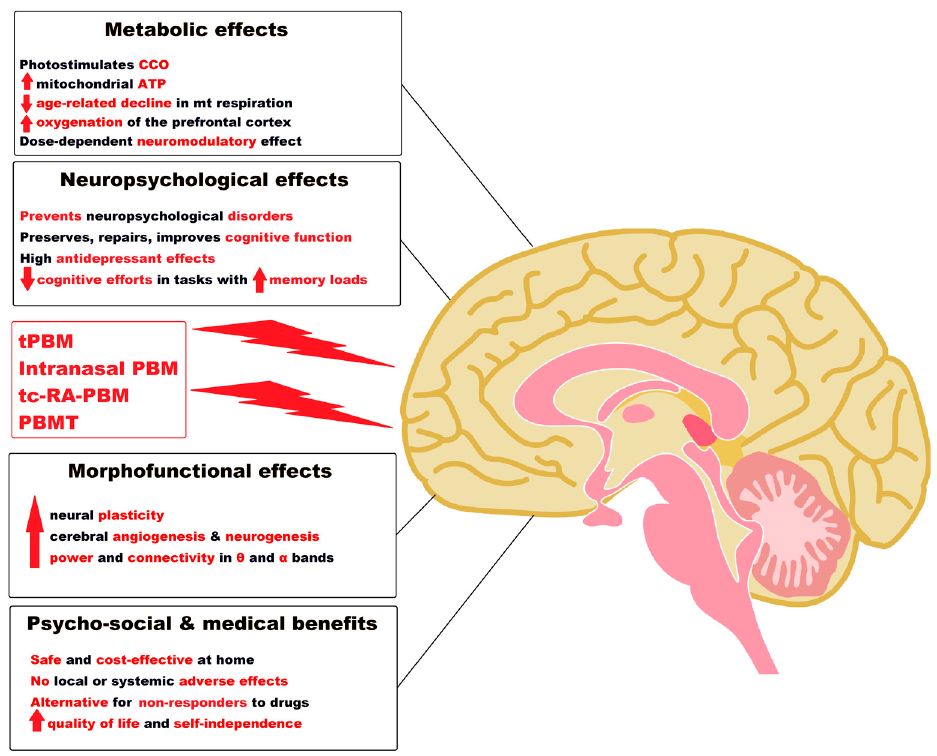
Figure 2. Notable effects of tPBM, intranasal PBM, tc-RA-PBM and PBMT as a “green” medicine in Alzheimer’s disease and dementia. Legend: ATP = Adenosine triphosphate; CCO = Cytochrome c oxidase; PBM= Photobiomodulation; mt = mitochondrial; tPBM = Transcranial PBM; tc-RA-PBM = Transcutaneous radial artery PBM; PBMT= Transcatheter Intracerebral PBM; α = alpha; θ = theta; ↑ = increase; ↓ = decrease. (Figure 2 was imagined and drawn by L.M.A. using Microsoft Paint 3D for Windows 10 and using completely free picture material (Open—Human Brain Png) from SeekPNG.com (accessed on 31 January 2023), for which we are very grateful).